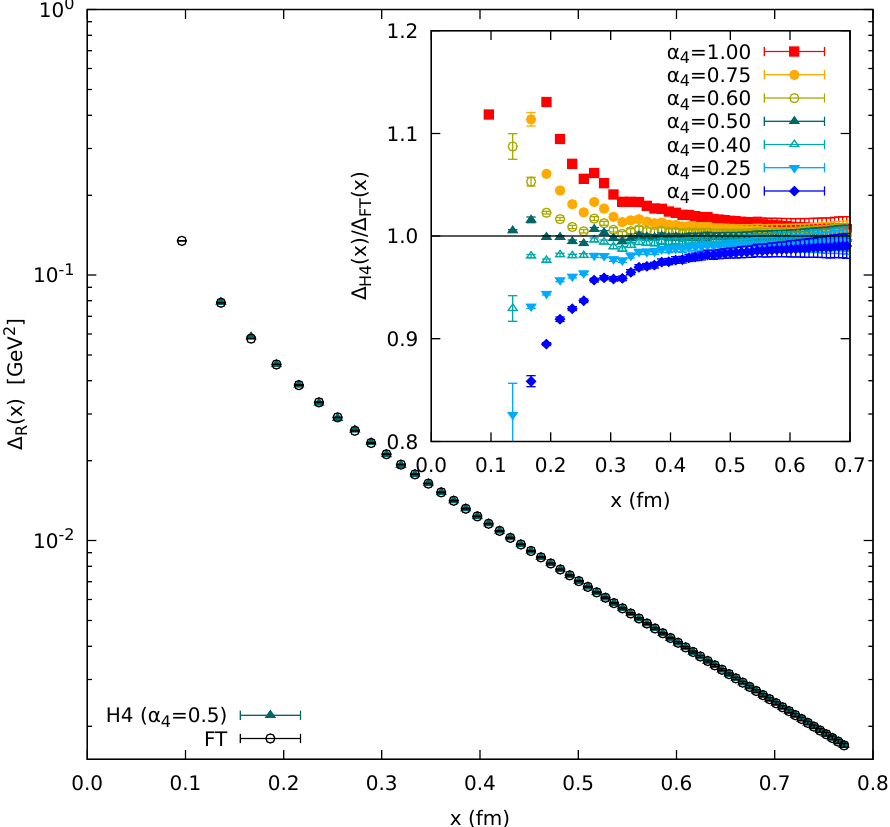
Figure 6. Gluon propagator in position-space for the H4 extrapolated data in position (purple full squares) and from the continuum Fourier transform of the momentum-space ones (open green circles, they are superimposed to the purple set except for the first point). The inset shows the ratio of the bare gluon propagators obtained from the application of H4 extrapolation in momentum space and the one coming from the Fourier transform of x-space ones. Each set corresponds to a different value of α for the extrapolations in position space (from top to bottom α 4